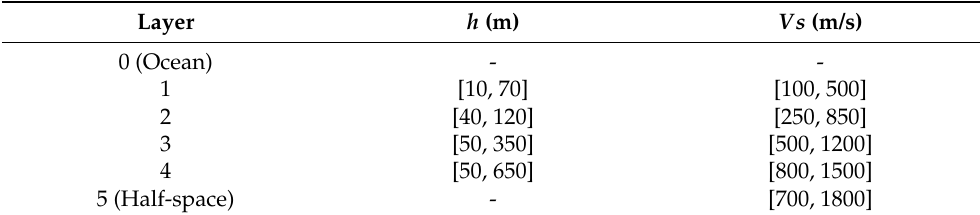
Table 5. Search bounds for Case 1.